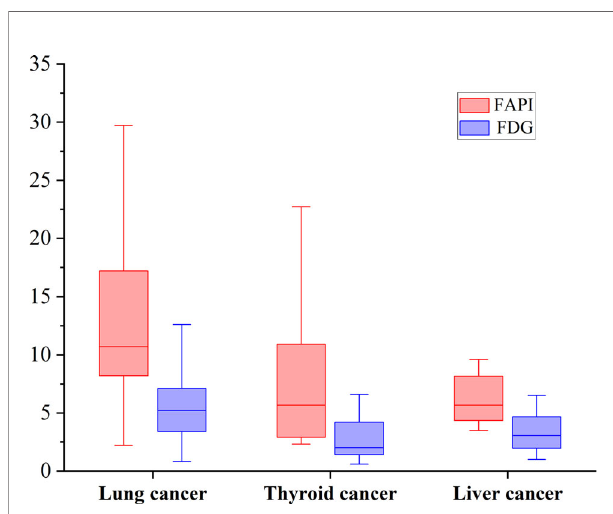
FIGURE 5 | The SUVmax of FAPI and FDG in bone metastases from lung cancer, thyroid cancer and liver cancer. [ 68 Ga]Ga-DOTA-FAPI-04 accumulation was signi fi cantly higher than that of [ 18 F]FDG in bone metastases from lung cancer (n = 62, median SUVmax, 10.7 vs 5.2; P < 0.01), thyroid cancer (n = 18, median SUVmax, 5.65 vs 2.1; P < 0.01) and liver cancer (n = 12, median SUVmax, 5.65 vs 3.05; P <